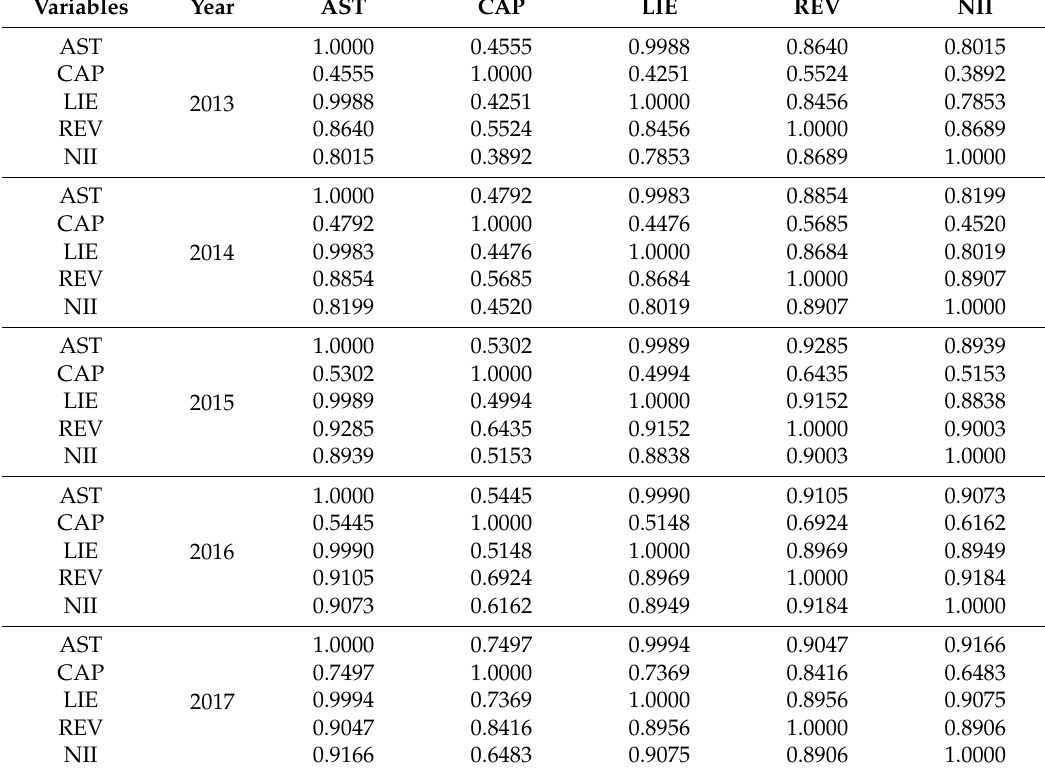
Table A2. Pearson’s correlation.